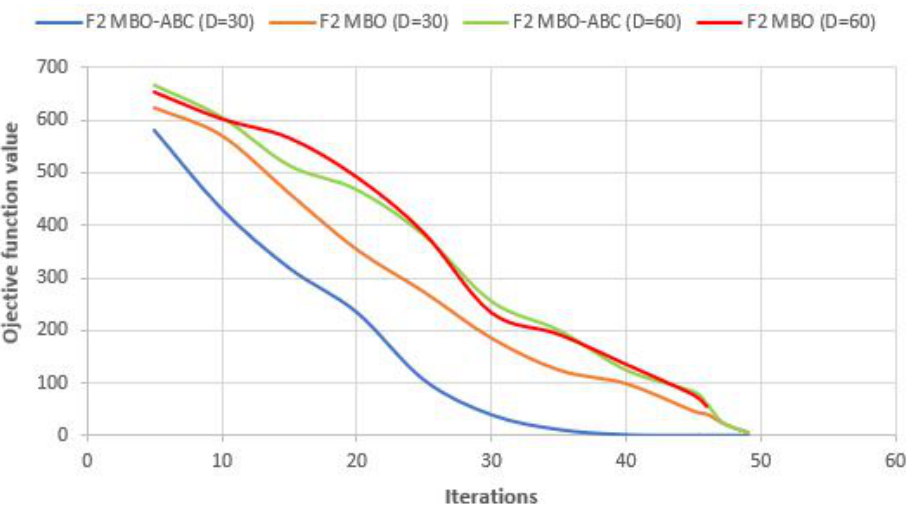
Figure 6. Convergence speed of MBO-ABC and MBO for F2 benchmark with D = 30 and D = 60.